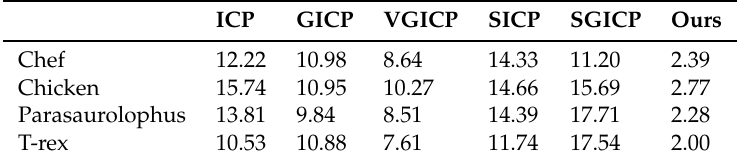
Table 3. Average processing time (s) of several methods at different noise levels on UAW